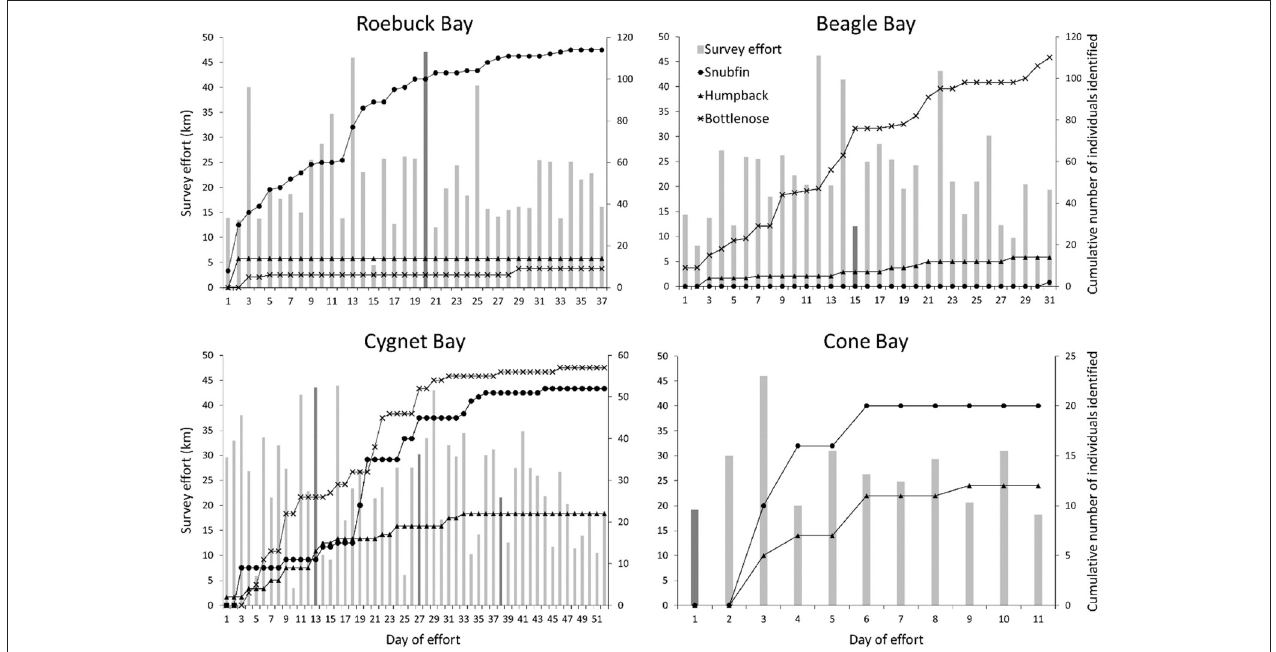
FIGURE 2 | Daily survey effort and cumulative number of distinctive dolphin individuals identified at each site. Vertical bars illustrate daily survey effort (left y-axis); a darker bar indicates the first day of effort in each sampling period. Lines illustrate the cumulative number of snubfin (circles), humpback (triangles), and bottlenose (crosses) dolphin individuals photo-identified (right y-axis). No figure is provided for the Inner Cambridge Gulf, where only one distinctive humpback dolphin individual was identified on the penultimate day of